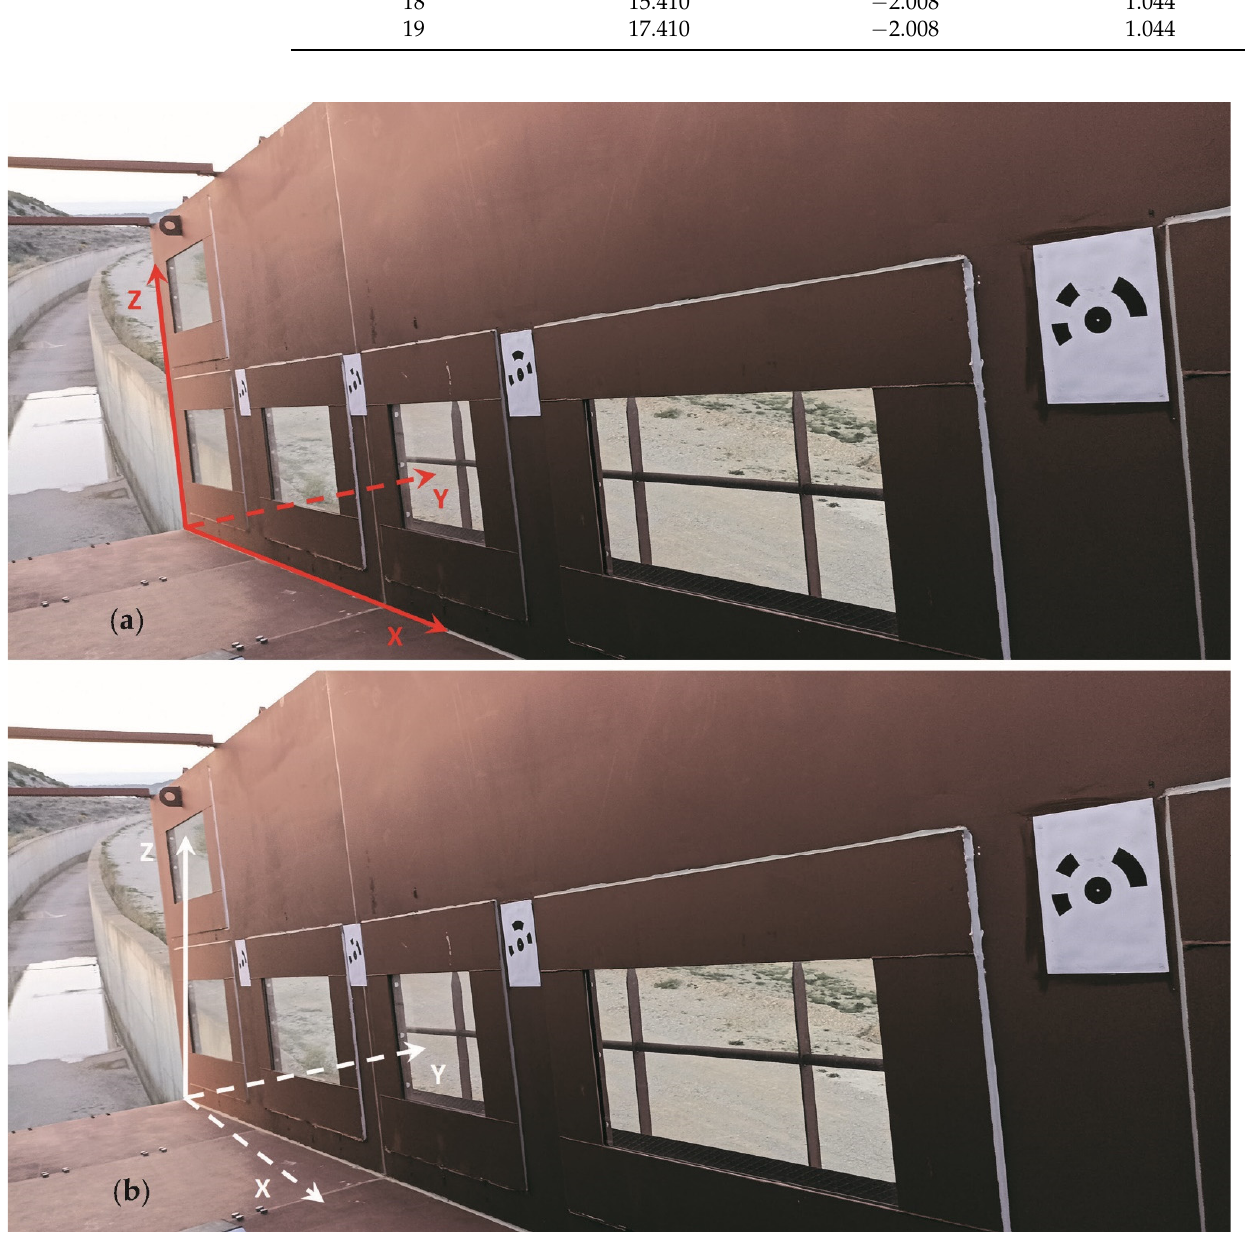
Figure 12. Location of the coordinate systems in the testing chute. Relative (( a ), red line) and absolute (( b ), white line).